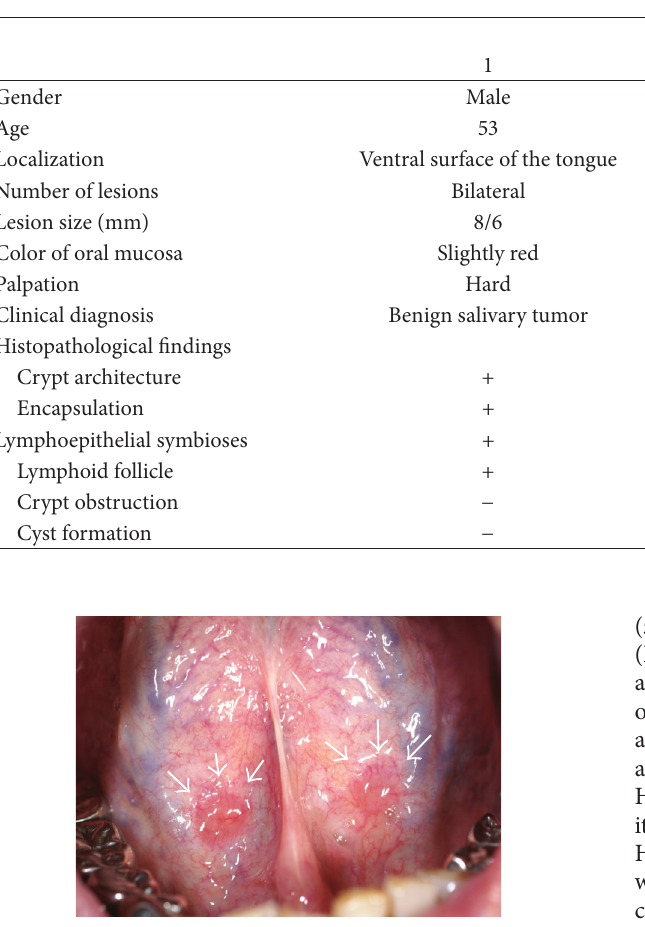
Table 2: Clinicopathological characteristics of three cases of ectopic tonsils.